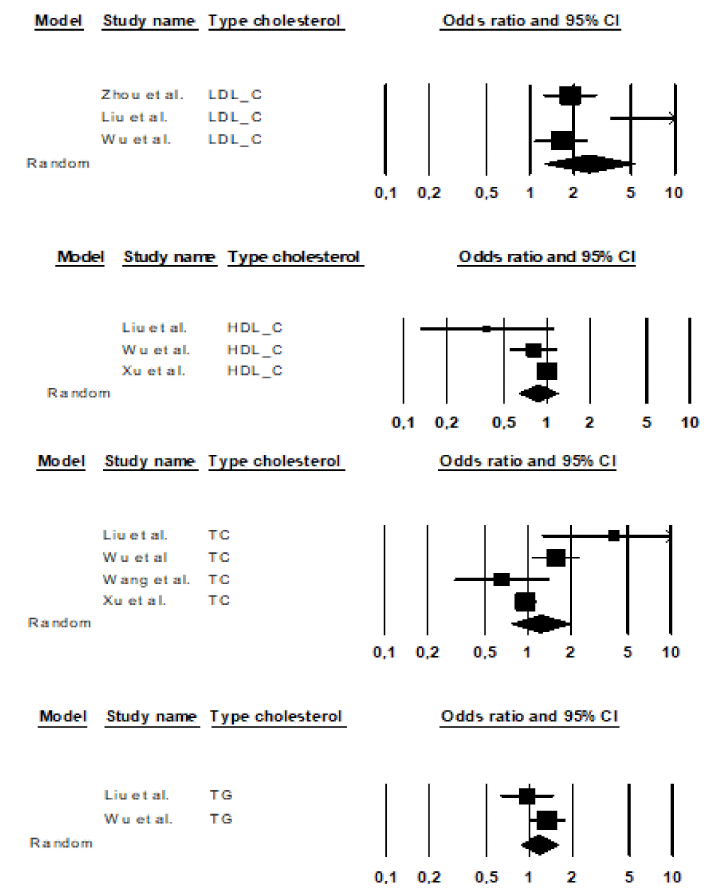
Figure 2. Forest plot of the effects of dyslipidemia on Alzheimer’s disease (AD): low-density lipoprotein cholesterol (LDL-C), high-density lipoprotein cholesterol (HDL-C), total cholesterol (TC), triglycerides